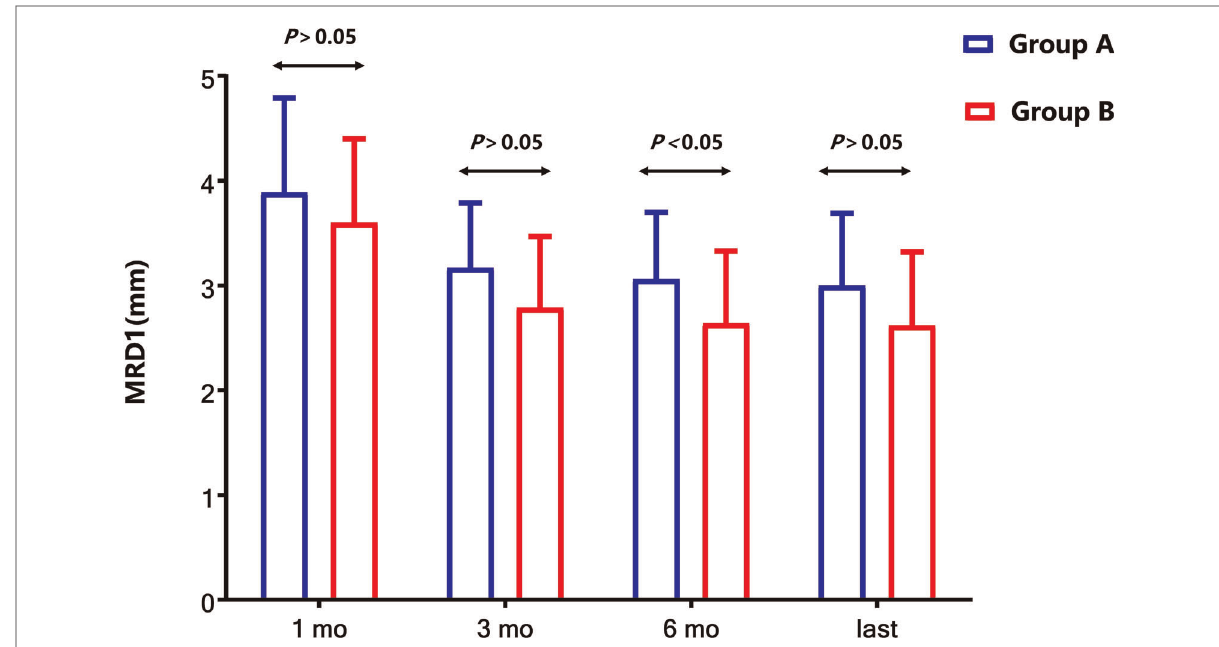
FIGURE 3 Comparison of MRD1 between two groups after surgery. Compared with the MRD1 values in group B, the values of MRD1 at 6 months after the operation were elevated signi fi cantly ( P <0.05), but those at the last follow-up were not signi fi cantly elevated ( P >0.05).